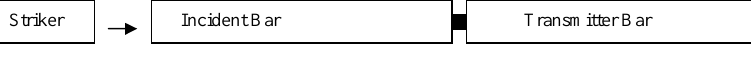
Fig. 1. Set-up of compressive split Hopkinson bar (not to